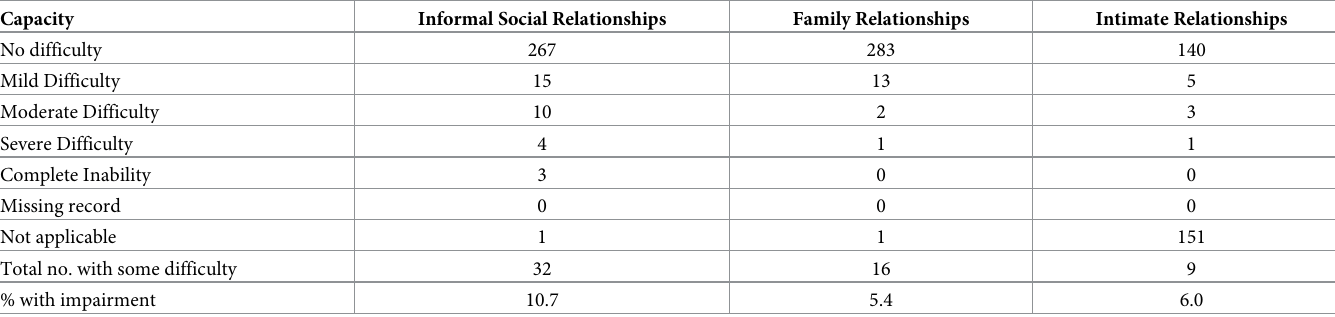
Table 7. Difficulties in interpersonal interactions and